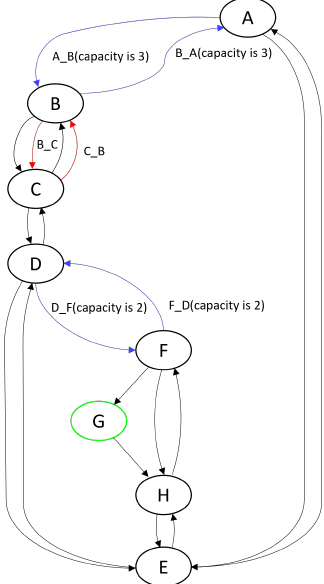
Figure 5. Physical network with